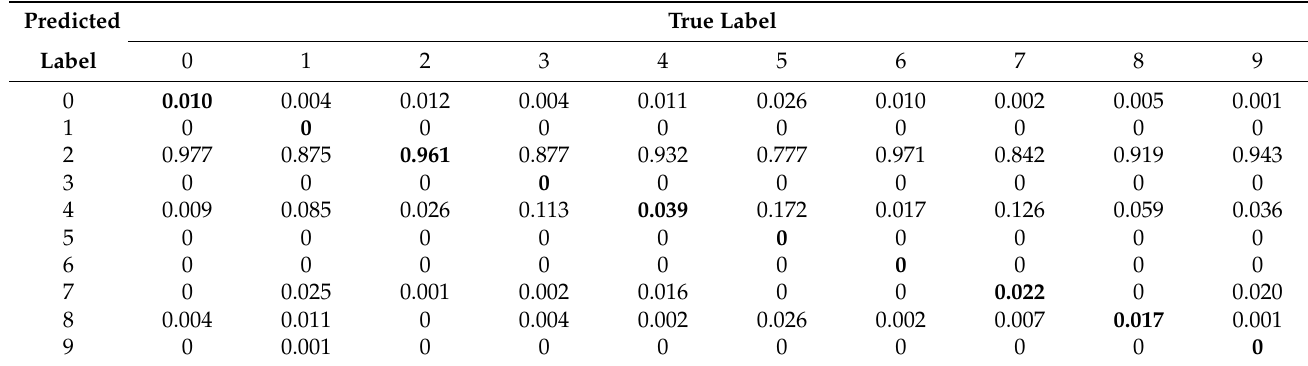
Table 3. Confusion matrix for hand writing character recognition of equal-weight combining based gradient updat- ing